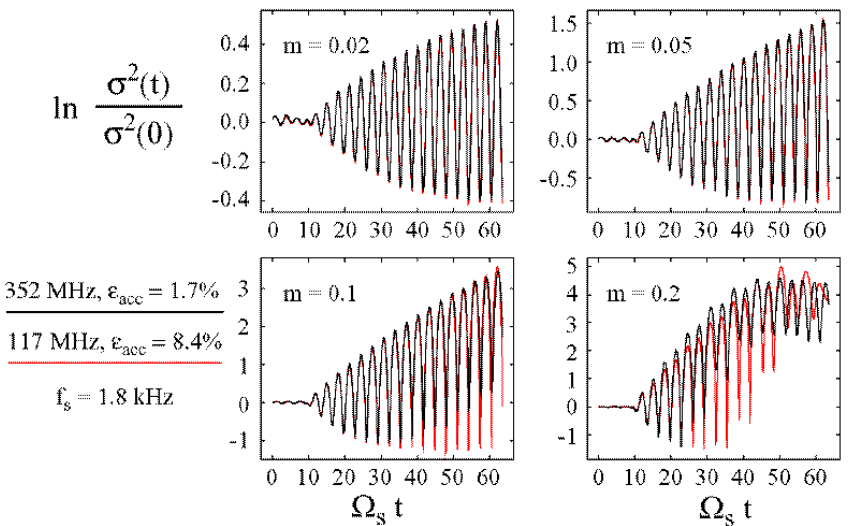
on bunch compression process (simulation). acc